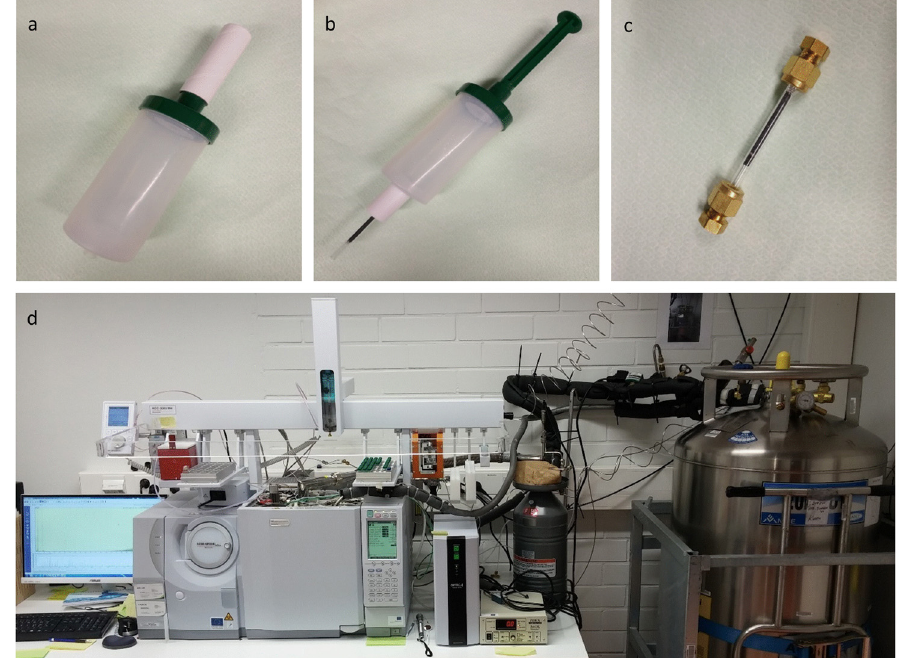
Figure 2. Exhaled breath analysis. End-tidal exhaled breath was sampled with the Bio-VOC ® sampler ( a ), injected into a glass liner containing Tenax GR absorbent ( b ), removed to laboratory in a sealed liner ( c ), and analyzed with comprehensive two-dimensional gas chromatography–mass spectrometry ( d ).